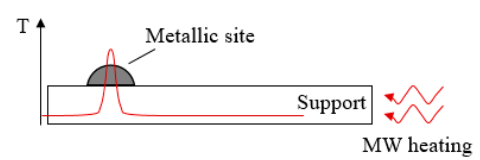
Figure 6. Localized temperature increment with microwave heating.